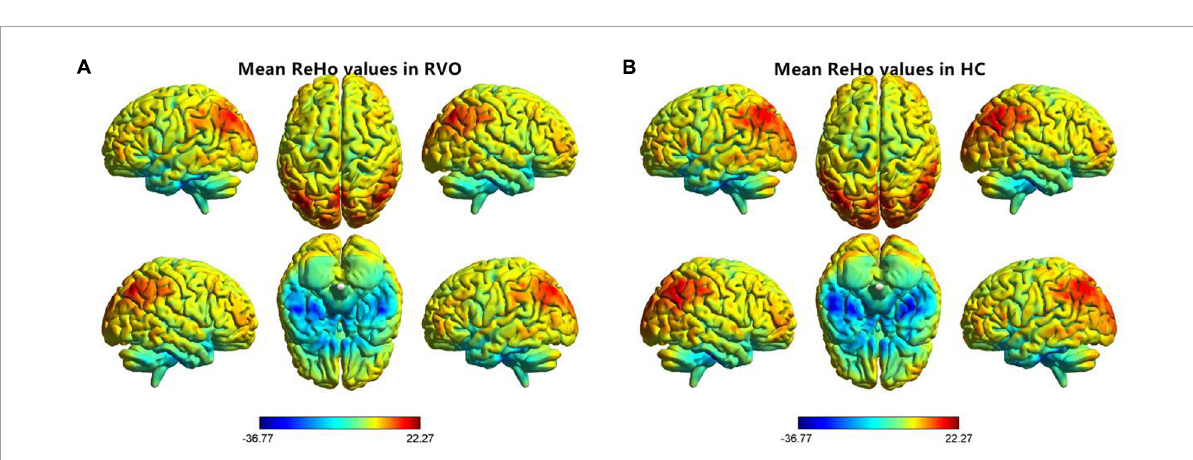
FIGURE2 Distribution patterns of the ReHo value at the group level in patients with RVO and HCs. One-sample t- test result of ReHo maps within the RVO (A) and HCs (B) . The color bar represents the t values. RVO, retinal vein occlusion; HC, health controls; ReHo, regional homogeneity; L, left; R,